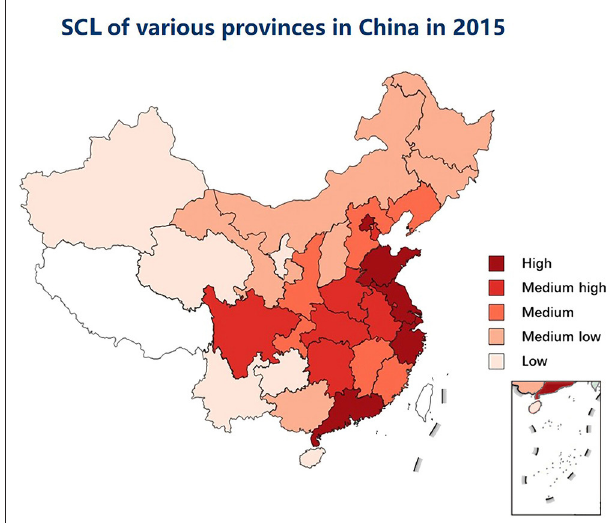
FIGURE 2 | SCL of various provinces in China in 2015.